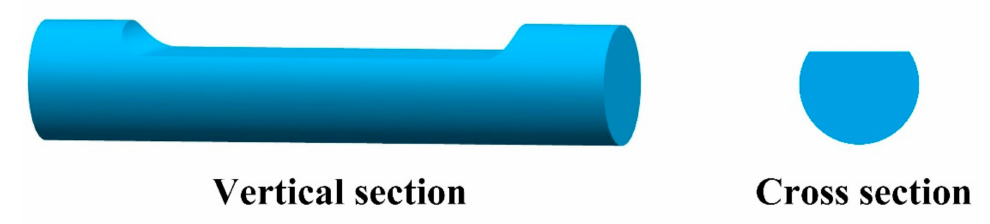
Figure 11. The schematic diagram of the side-polished